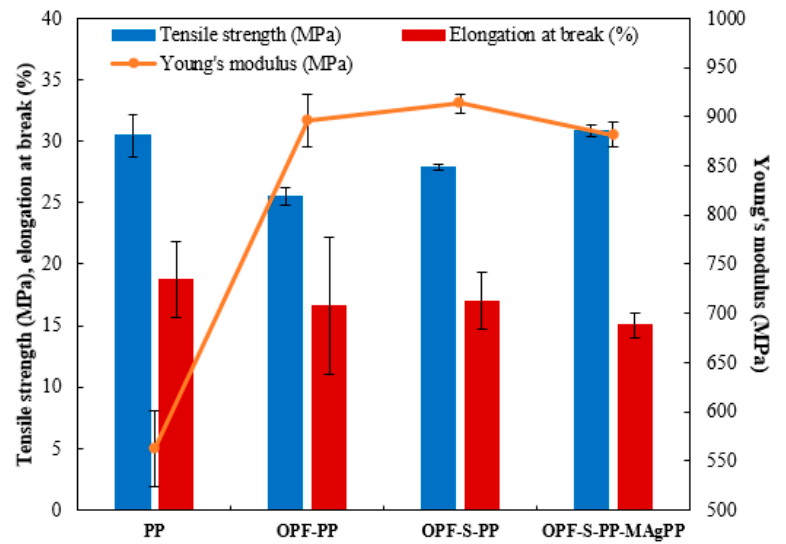
impact strength caused by the inability of compatibilizer to improve interfacial adhesion between the reinforcing natural fiber and polymer matrix [44]. Figure 7. Tensile properties of PP, OPF-PP, S-OPF-PP, and S-OPF-PP-MAgPP composites.